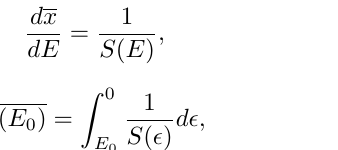
Fig. 5. Electronic and nuclear stopping power of a U235 light fis- sion fragment from SRIM. For convenience, the stopping power is in MeV/(mg.cm − 2 ).